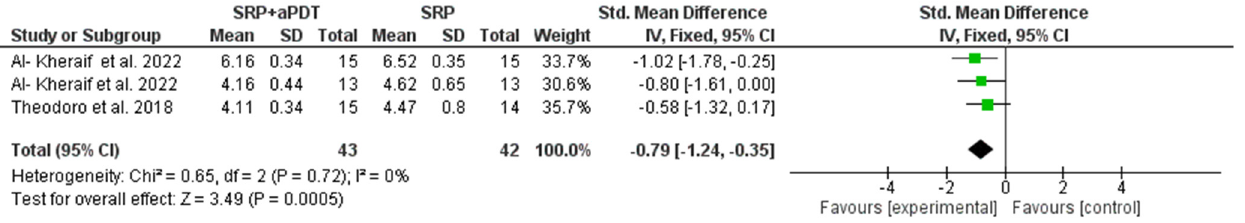
Figure 5. Forest plot of CAL gain at 6 months.